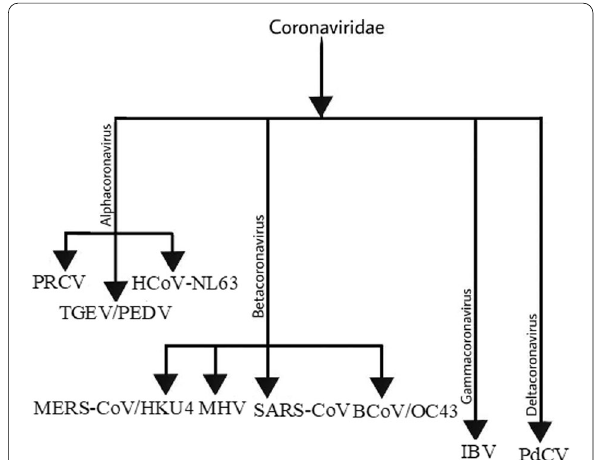
Fig. 3 Genera Alphacoronavirus including viruses that can infect human population example Including human coronavirus (HCov-NL63), porcine respiratory coronavirus (PRCV) and porcine transmissible gastroenteritis coronavirus (TGEV) and Betacoronaviruses which includes viruses that can infect human beings e.g., Bat coronavirus HKU4, SARS-CoV, mouse hepatitis virus (MHV), human coronavirus (OC43), bovine coronavirus(BCoV), and MERS-CoV. Gammacoronavirus includes viruses that are capable of infecting the avian population whereas Deltacoronavirus comprises viruses that can effectively infect mammalian as well as avian species e.g., Including infectious bronchitis coronavirus (IBV) and procrinedeltacoronavirus (PdCV), respectively